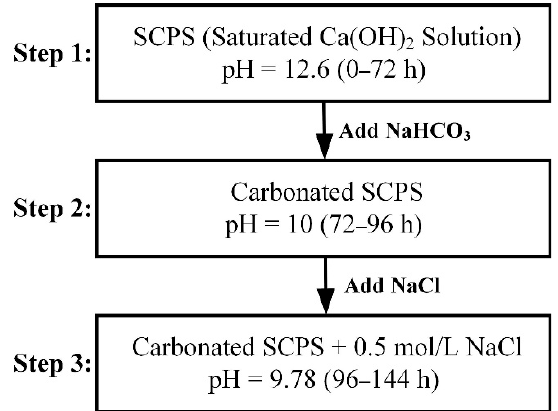
Figure 3. The test procedure.